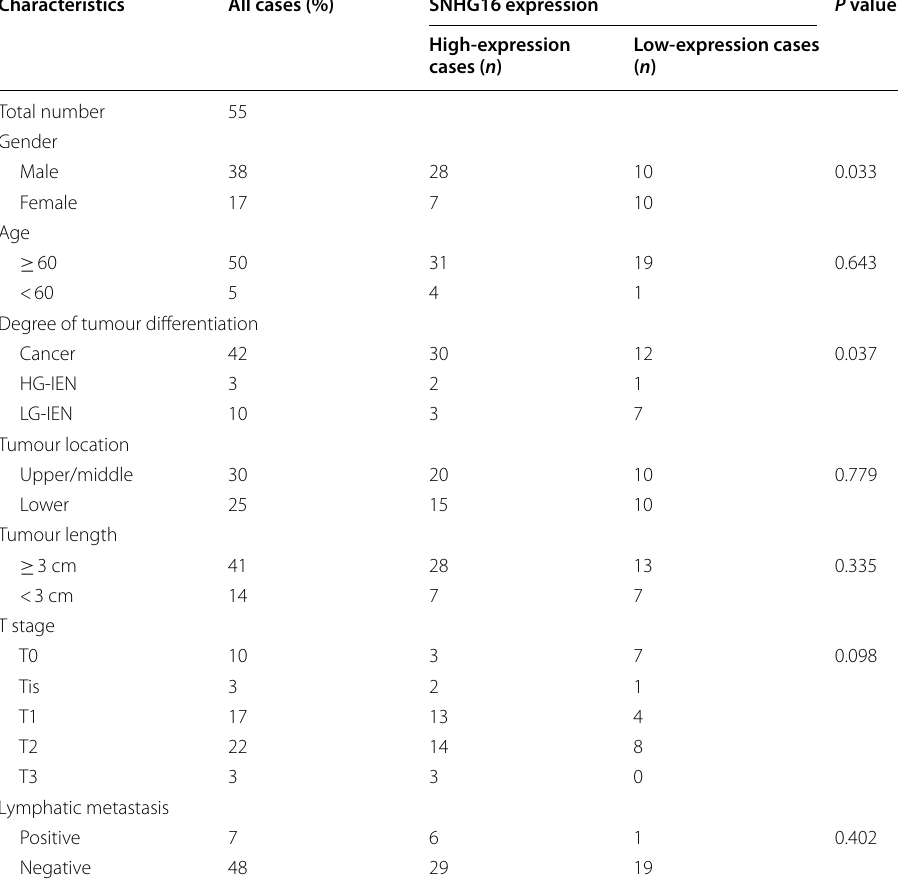
Table 1 Correlation between SNHG16 expression and clinical pathological characteristics of ESCC